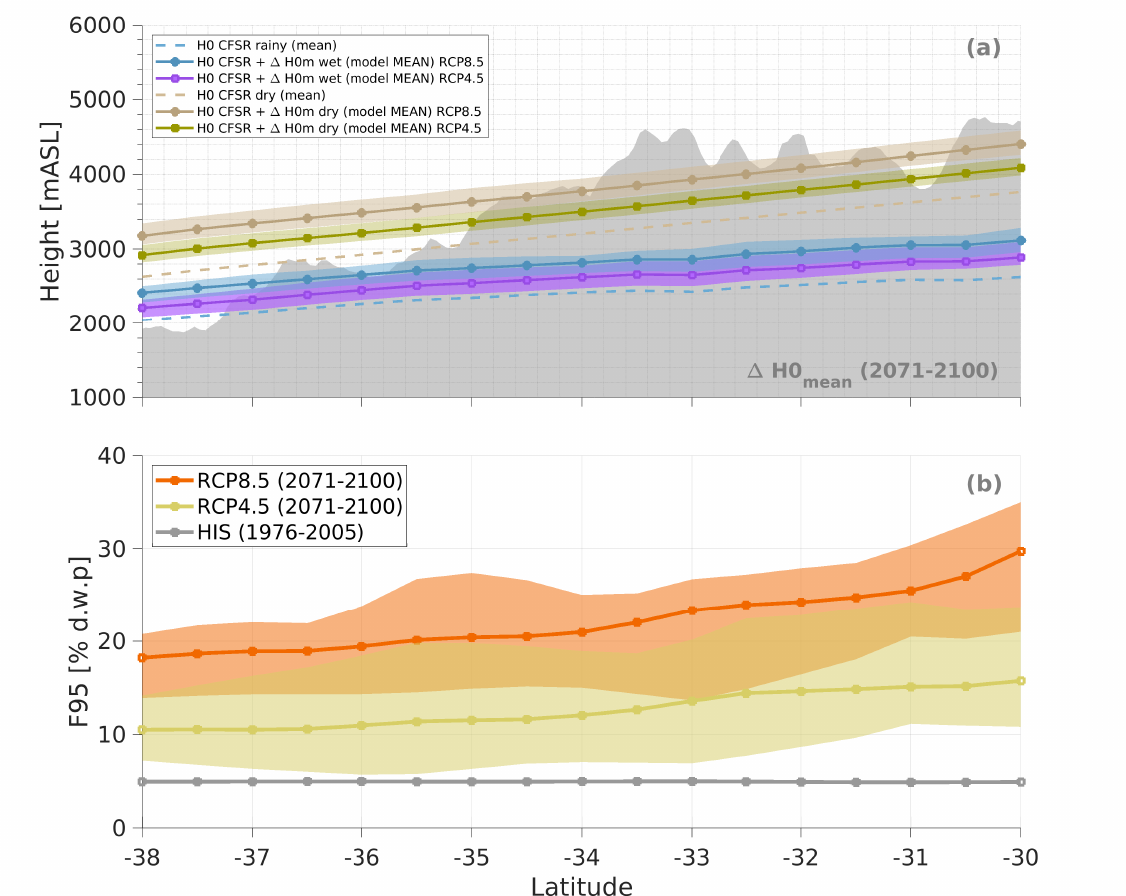
Figure 7. ( a ) Dashed lines indicate the profile of the mean H 0 along the coast of central Chile in present climate based on CFSR data for wet days (blue) and dry days (brown). The solid lines with circles are the multimodel mean H 0 for the end of 21st century under RCP8.5/RCP4.5 and the shading indicates the projection range (maximum-minimum). Gray shaded area indicate the 97.5th percentile of terrain elevation. ( b ) End of the century (2071–2100) multimodel mean frequency of the 95th percentile H 0 value in the present climate. The line with circles and the shaded area represent the average and range (minimum and maximum) projected by the